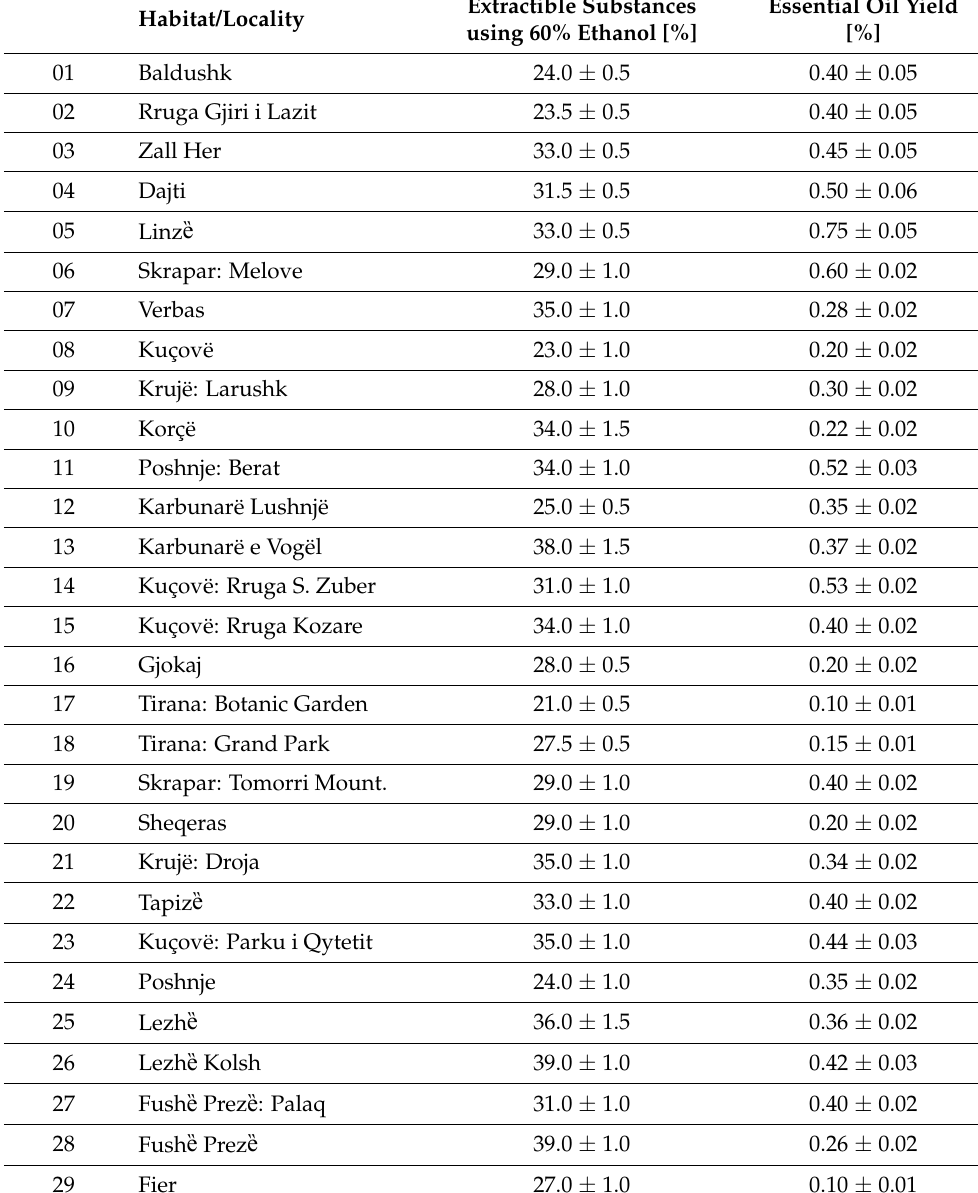
Table 2. Chamomile inflorescence’s yield of essential oil in % ( v / w – expressed as a dry